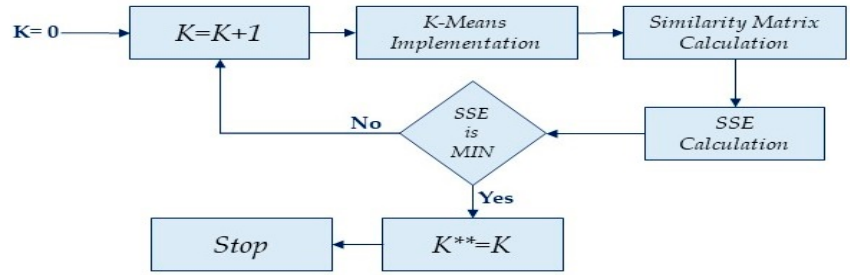
Figure 6. K** calculation flowchart.